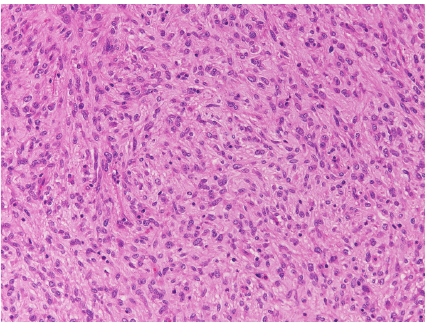
Figure 3: Microscopically image: histological examination shows scattered lymphocytes and plasma cells are admixed with spindle cells, hematoxylin and eosin stain, original magnification 200x.